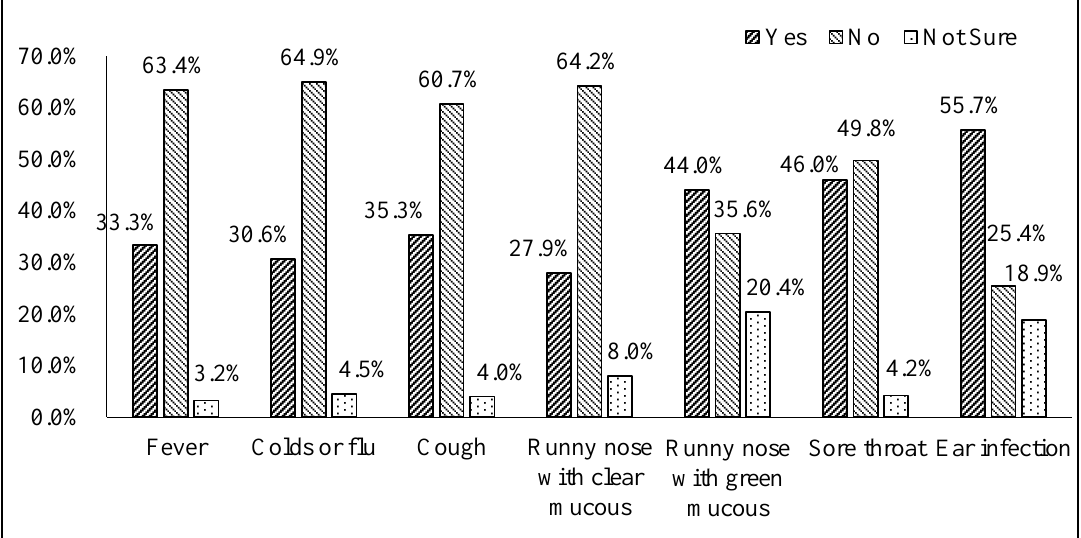
Table 4. Respondents’ mean knowledge score and expectation on antibiotic use (n = 402).